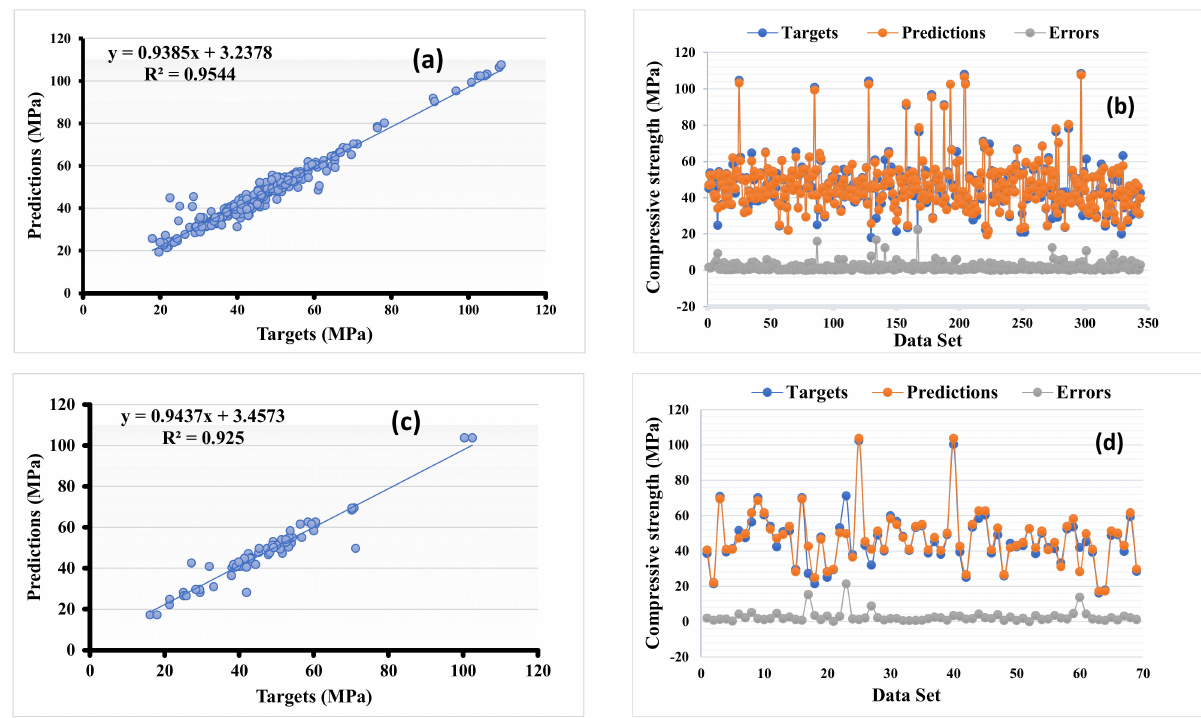
Figure 3. Numerical analysis results illustrating the relationship among the actual and predicted outcomes and reflection of errors distribution of the models. ANN ( a , b ); GEP ( c , d